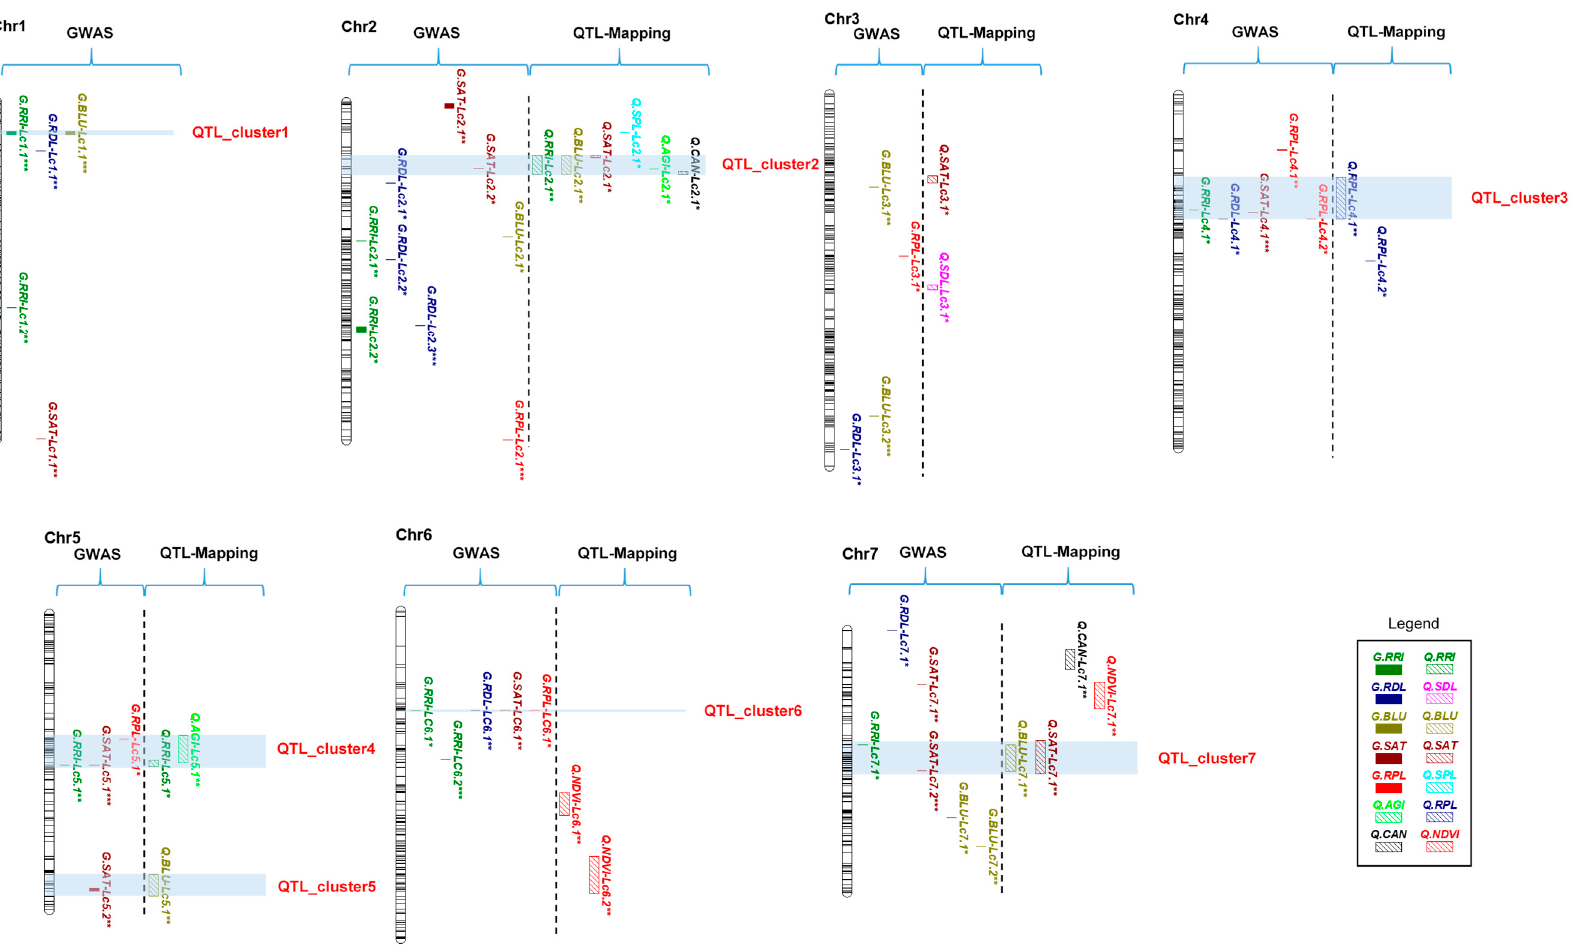
Figure 4. Genetic map of ARR resistance QTL identified using QTL mapping and genome-wide association study (GWAS). The solid bars represent GWAS-based QTL, and the hollow bars indicate QTL-mapping-based QTL. QTL clusters are highlighted by blue-shaded banding. QTL significance levels are labeled using *** for major QTL, ** for nominal QTL, * for suggestive QTL .